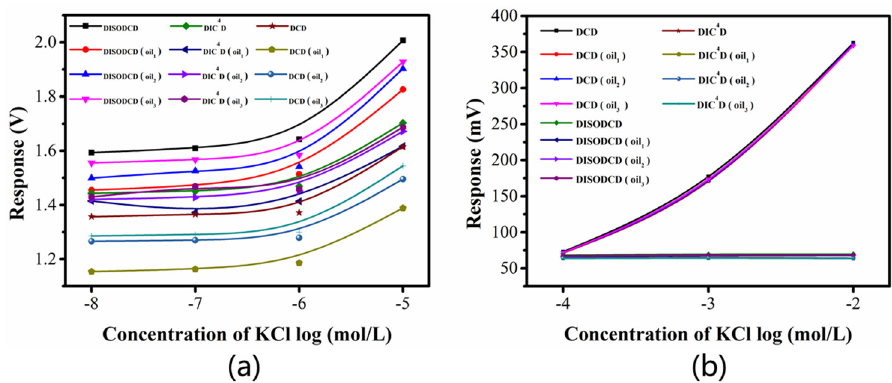
Figure 9. Signal response diagram of DCD, DIC 4 D, and DISODCD sensors to KCl solution disturbed by oil impurities. ( a ) Response graphs of 0.01–10 μ M KCl solution were tested 3 times; by oil impurities. ( a ) Response graphs of 0.01–10 µ M KCl solution were tested 3 times; ( b ) Response ( b ) Response graphs of 0.1–10 mM KCl solution were tested 3 times. graphs of 0.1–10 mM KCl solution were tested 3